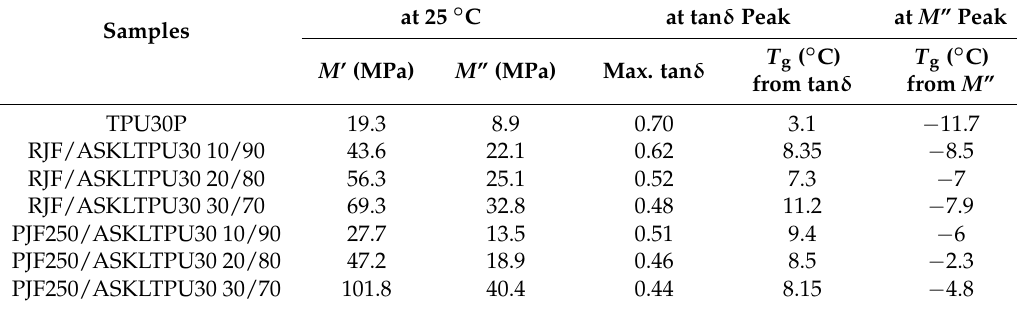
Table 2. Specific results of dynamic mechanical analysis of JF reinforced